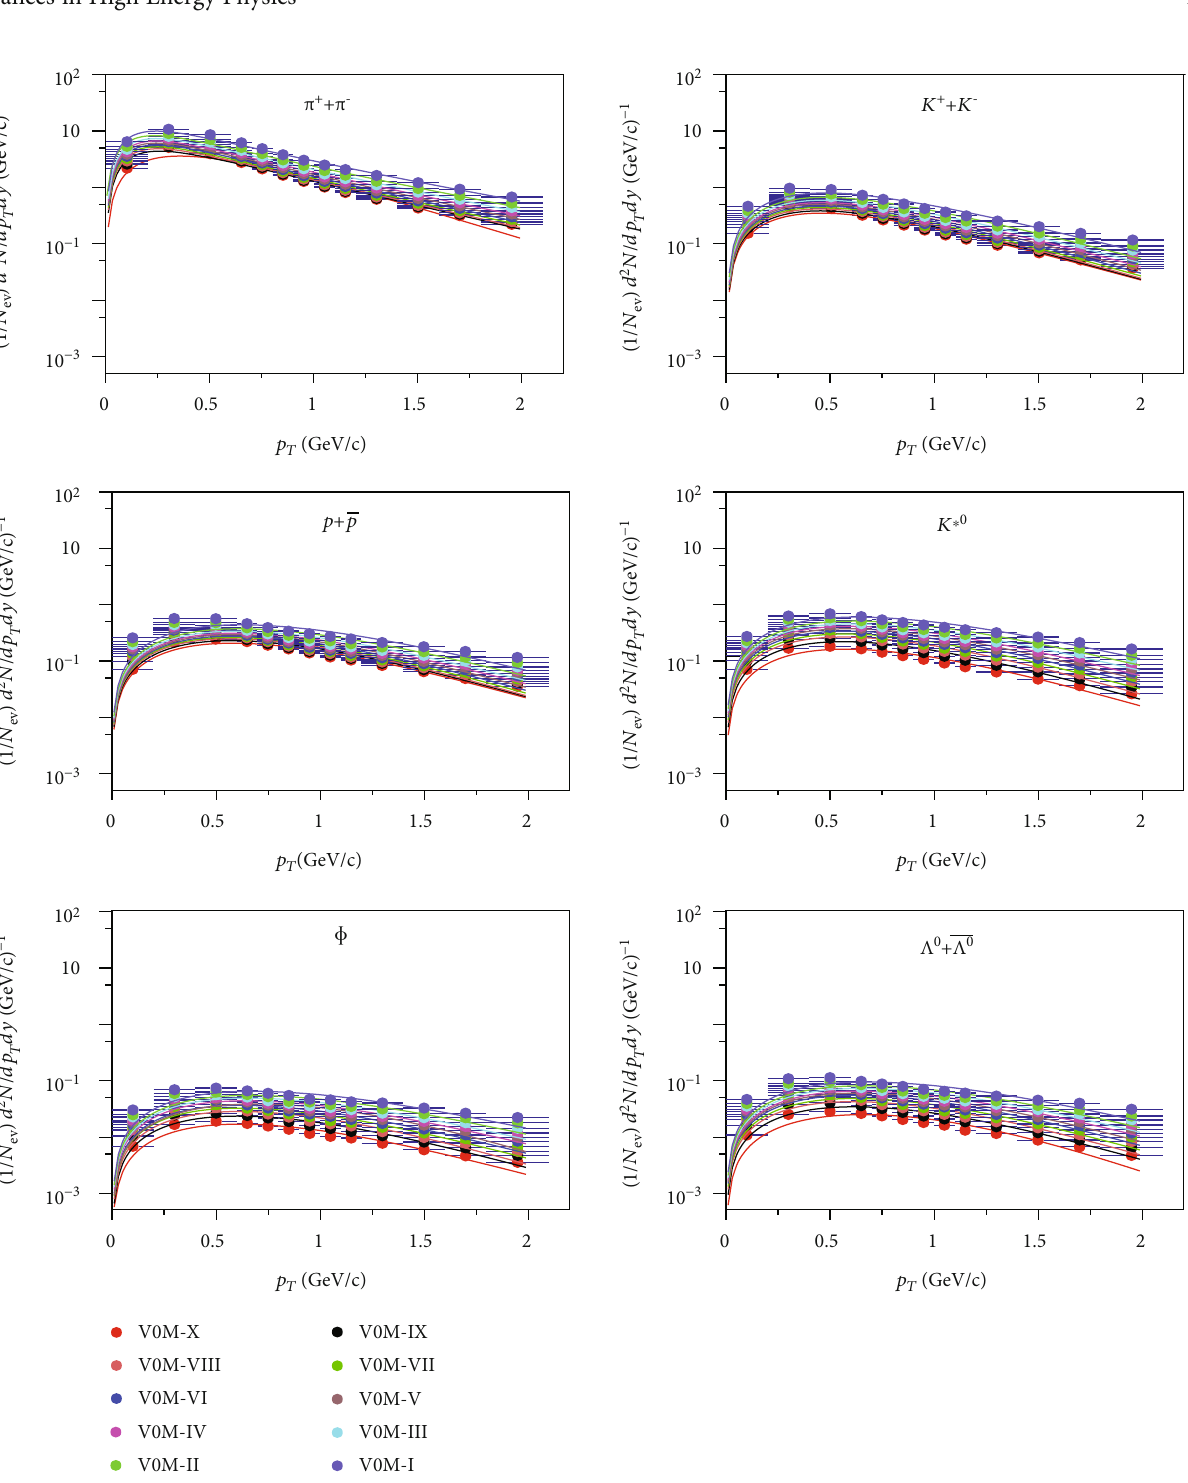
-spectra of identi fi ed hadrons from PYTHIA8 using the BGBW model for jetty events in T